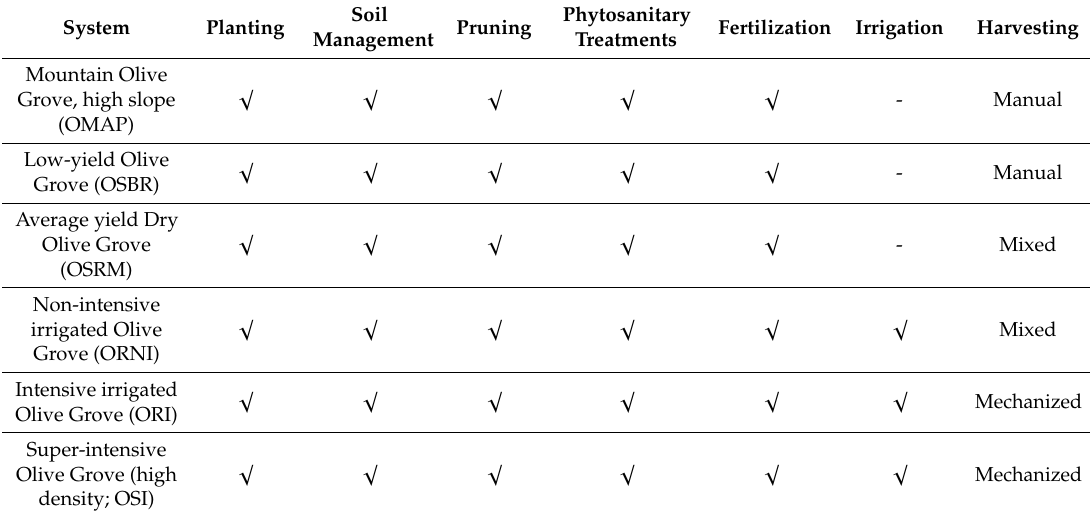
Table 2. Tasks of the di ff erent olive cultivation systems